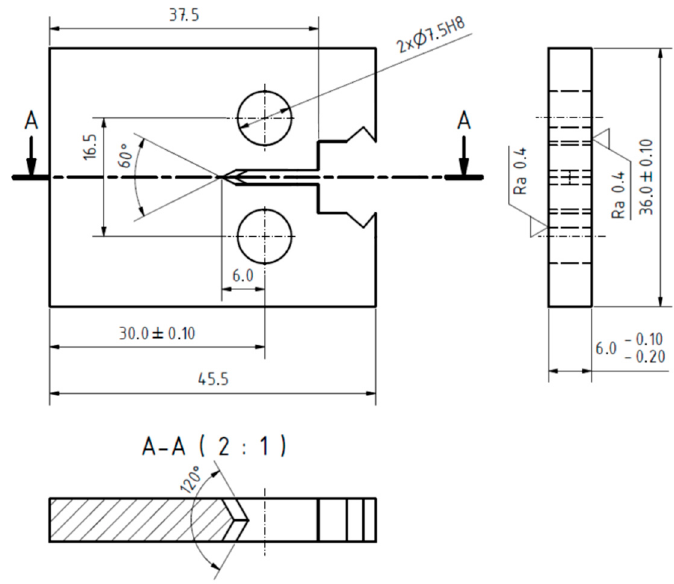
Figure 18. CT specimen used for determination of crack closure behavior. (Unit: mm)